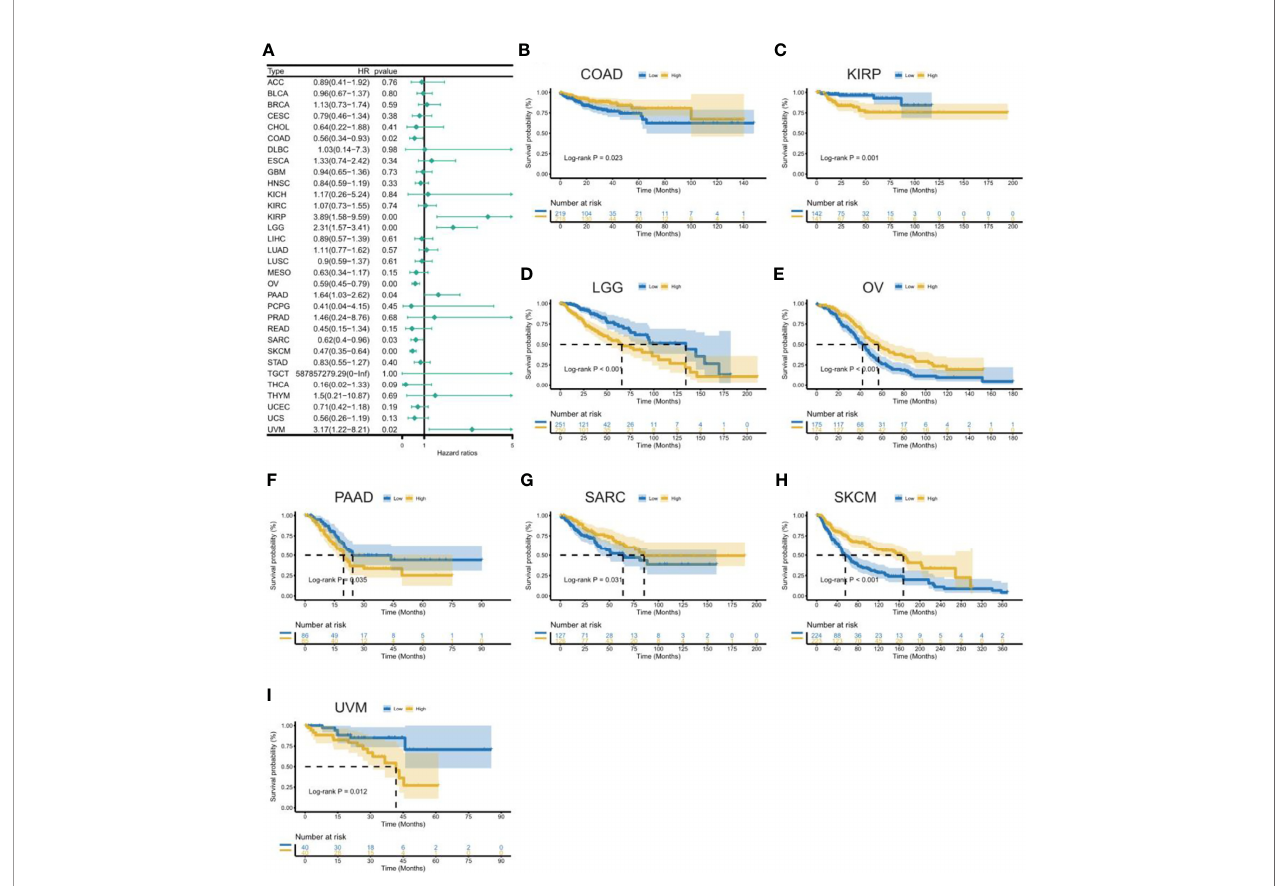
FIGURE 4 | Association between CXCL11 expression and disease-speci fi c survival (DSS). (A) Forest plot of DSS association with CXCL11 expression across cancers. (B – I) Kaplan – Meier analysis of the association between CXCL11 expression and DSS in COAD, KIRP, LGG, OV, PAAD, SARC, SKCM, and UVM.